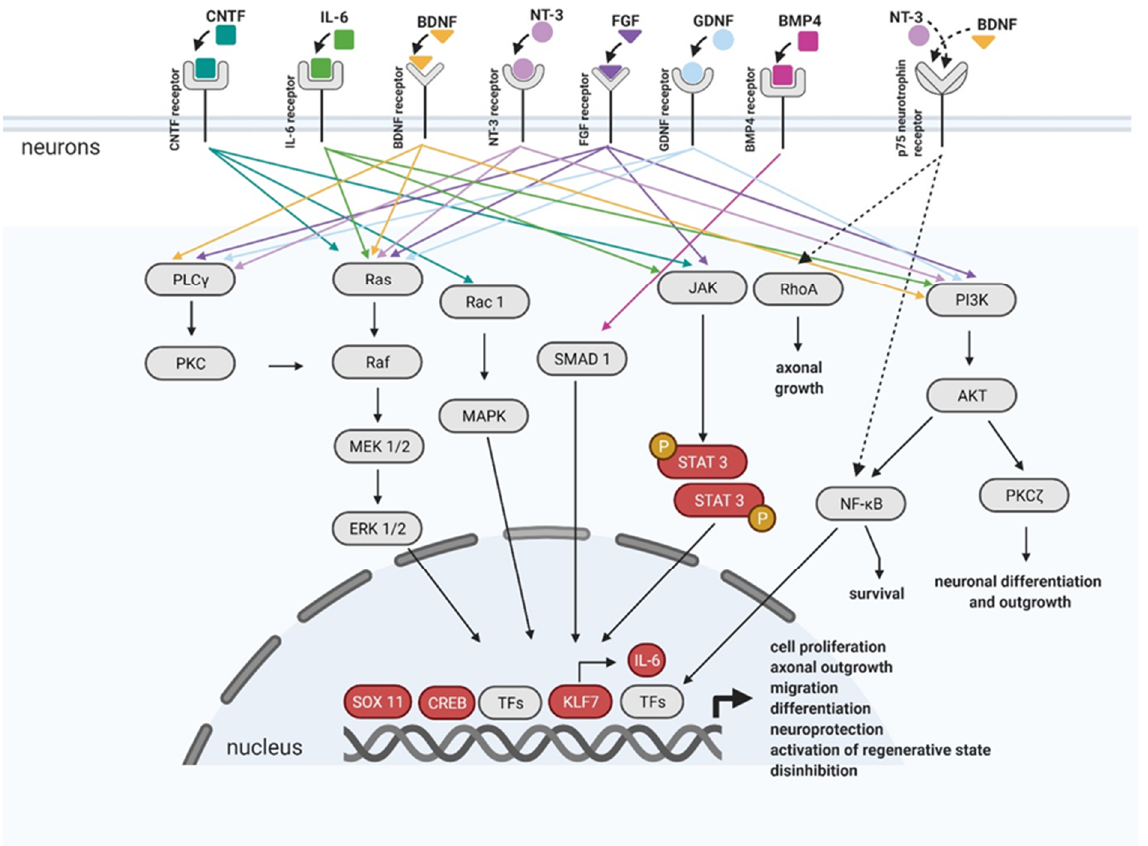
Figure 4. Schematic representation of connections between pro-regenerative factors and transcription factors (TFs) targeted in AAV-mediated gene therapy. Pro-regenerative factors and TFs mentioned in the text above the figure are marked in colors (Created with BioRender.com).